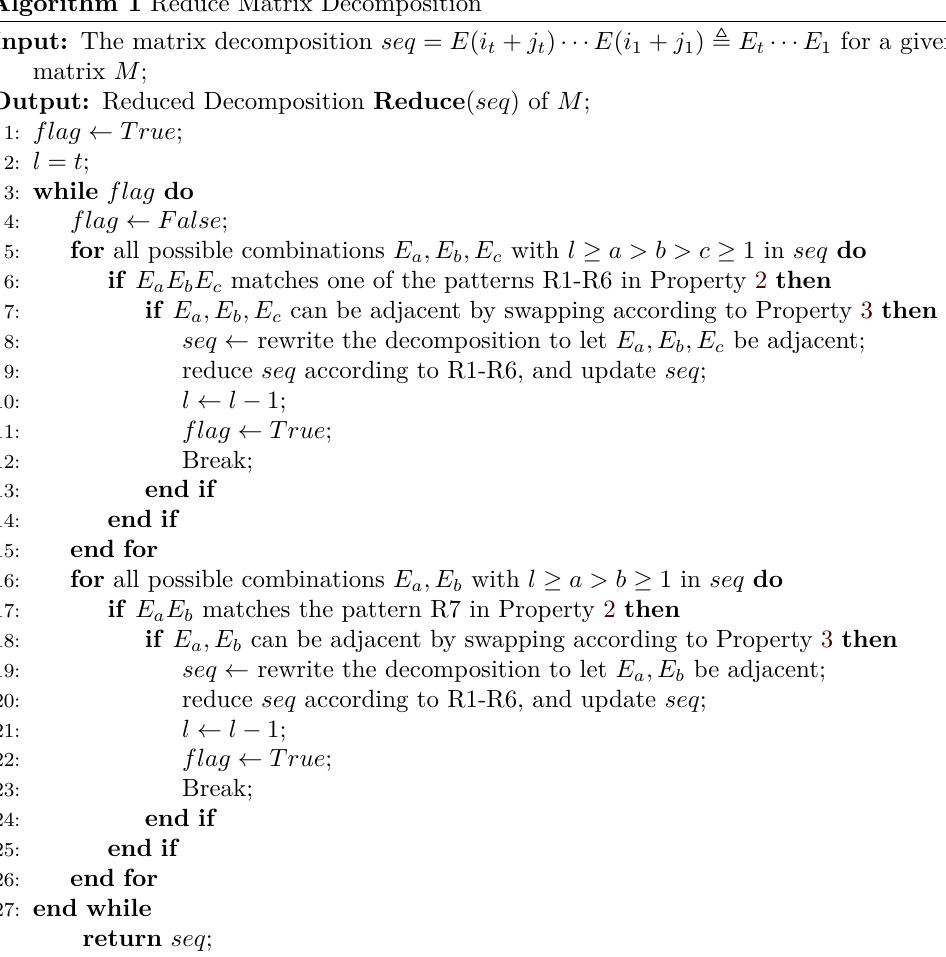
Algorithm 1 Reduce Matrix